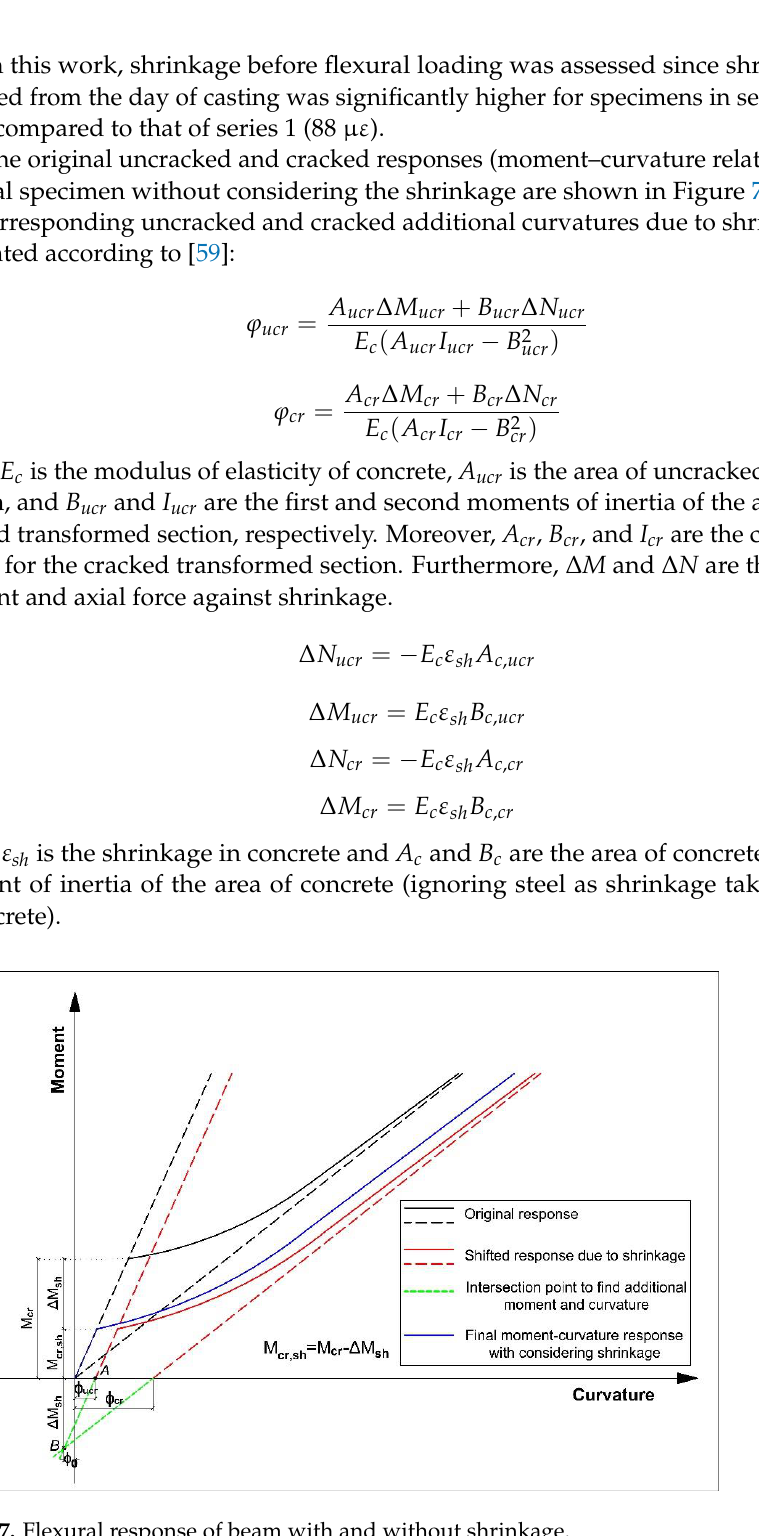
Figure 8. Analytical predictions of load–deflection curves with and without accounting for the shrinkage effect for specimens ( a ) CB-1-R; ( b ) SB1S-1-R; ( c ) CB-2-R; and ( d ) SB2S-2-R. 3.2. Load–Deflection Curves